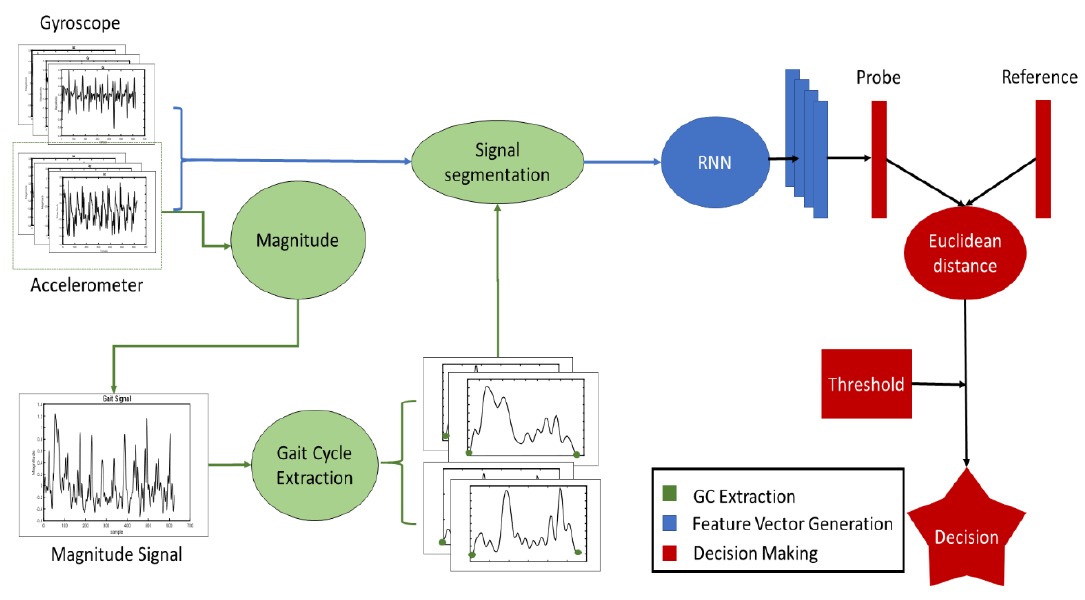
Figure 2. Algorithm schema. GC: gait cycle; RNN: Recurrent Neural Network.